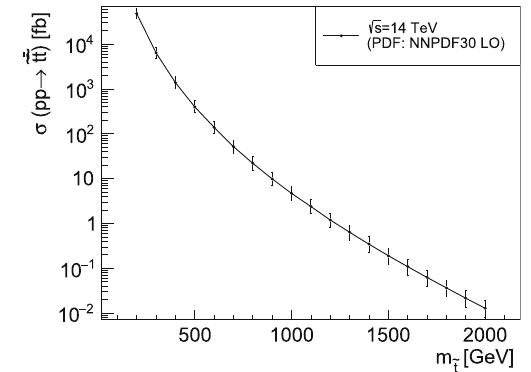
√ ˜¯ t ) at s = 14 TeV as